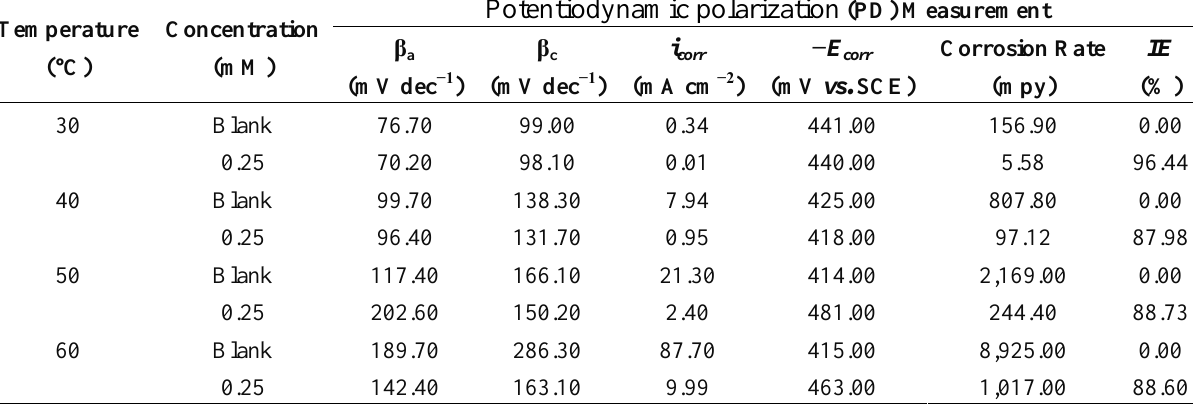
corrosion inhibitor at different